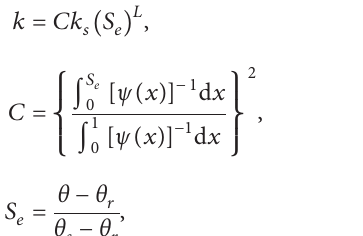
Figure 7: Relationship between permeability coefficient and matrix suction of unsaturated compacted loess: (a) ρ ρ d � 1.50g/cm 3 , (c) ρ d � 1.60g/cm 3 , and (d) ρ d � 1.70g/cm 3